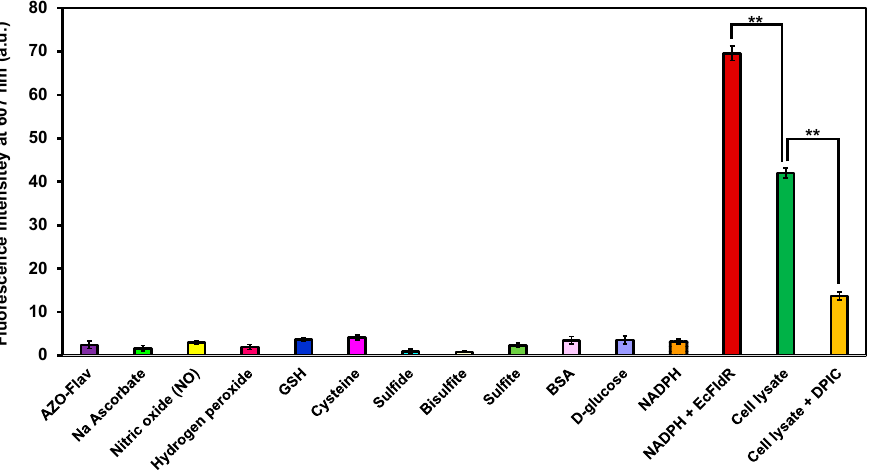
Figure 5. Selectivity of AZO-flav (10 μ M) towards Ec FldR incubated in 100 mM hypoxic phosphate buffer (pH 7.4) containing NADPH (50 μ M) and either Na ascorbate (1 mM), nitric oxide (100 μ M), hydrogen peroxide (100 μ M), GSH (10 mM), cysteine (1 mM), sulfide (1 mM), bisulfite (1 mM), sulfite (1 mM), BSA (1 mg mL -1 ), D -glucose (1 mM), NADPH (100 μ M), HepG2 cell lysate extract, or HepG2 cell lysate extract with DPIC compared with AZO-Flav (10 μ M) alone without enzyme. All samples were incubated for 5 min at 37 °C before measuring fluorescent spectra (excitation wavelength = 540 nm). Statistical analysis is based on T-test (** p < 0.01).